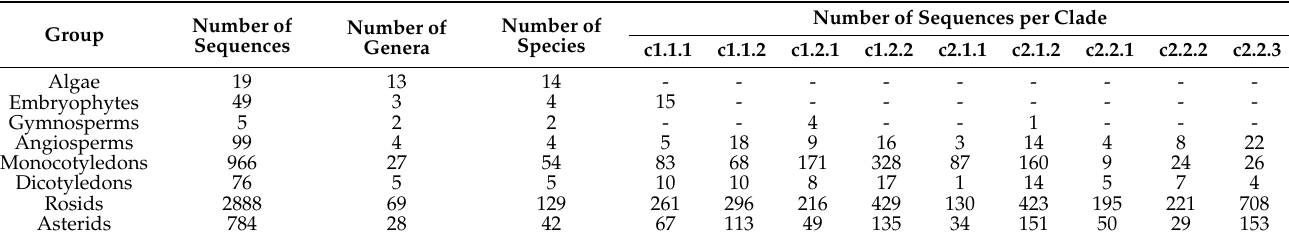
Table 1. A representation of the high-level taxonomic groups in the MLO